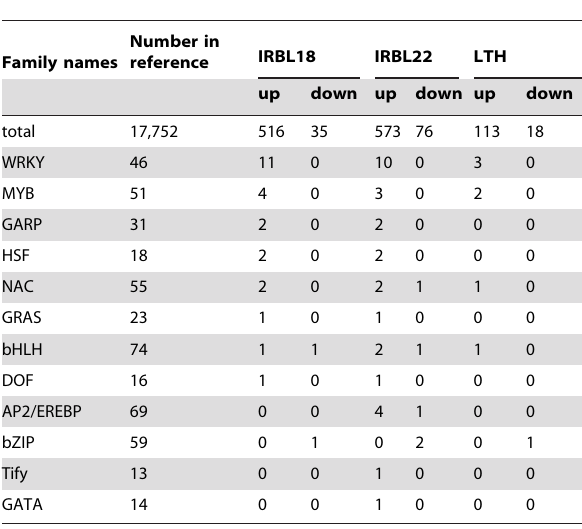
Table 5. The summary of differentially regulated transcription factor